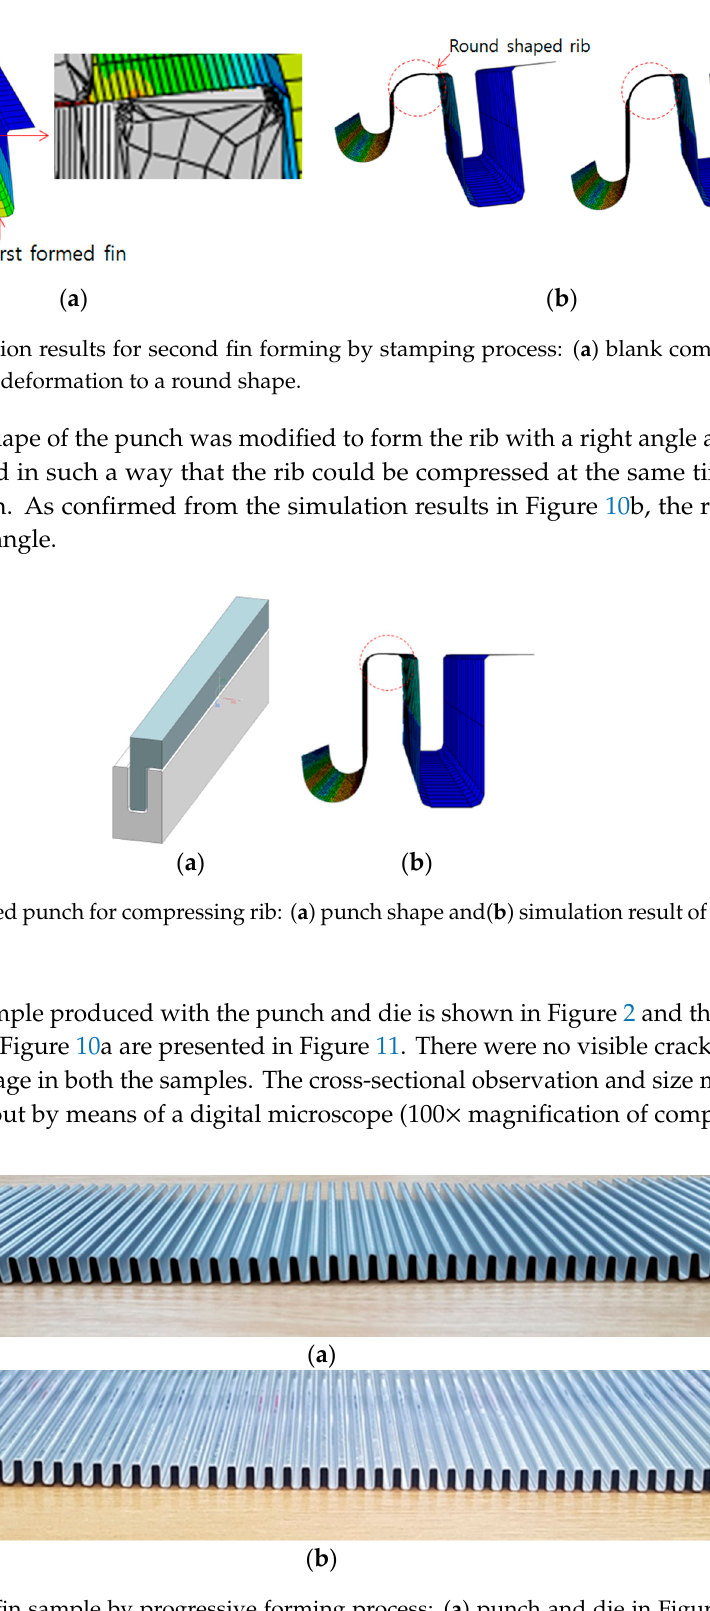
Figure 11. Inner fin sample by progressive forming process: ( a ) punch and die in Figure 2 and ( b ) punch and die in Figure 10a.